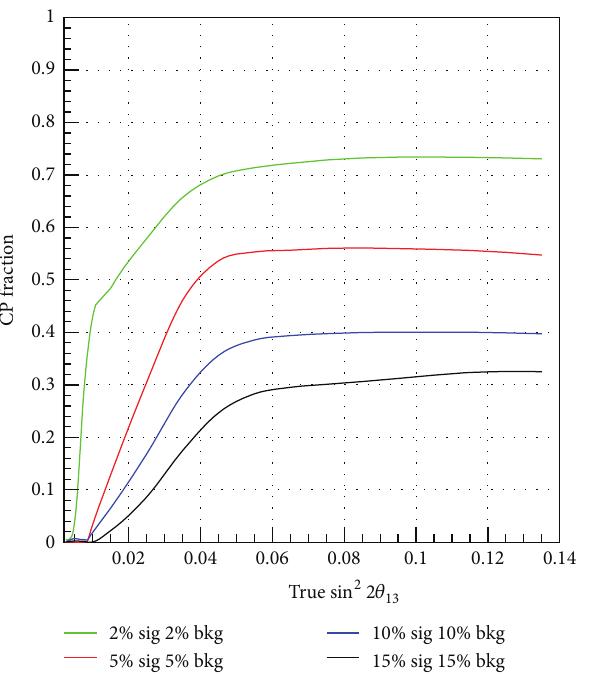
Figure 30: Sensitivity to leptonic CP violation of the MEMPHYS experiment at 3 𝜎 for different assumptions on the systematic error forthesignal(sig)andthebackground(bkg).Theevaluationisbased on the CERN to Fr´ejus Superbeam with 2 years running in neutrino mode and 8 years running in anti-neutrino